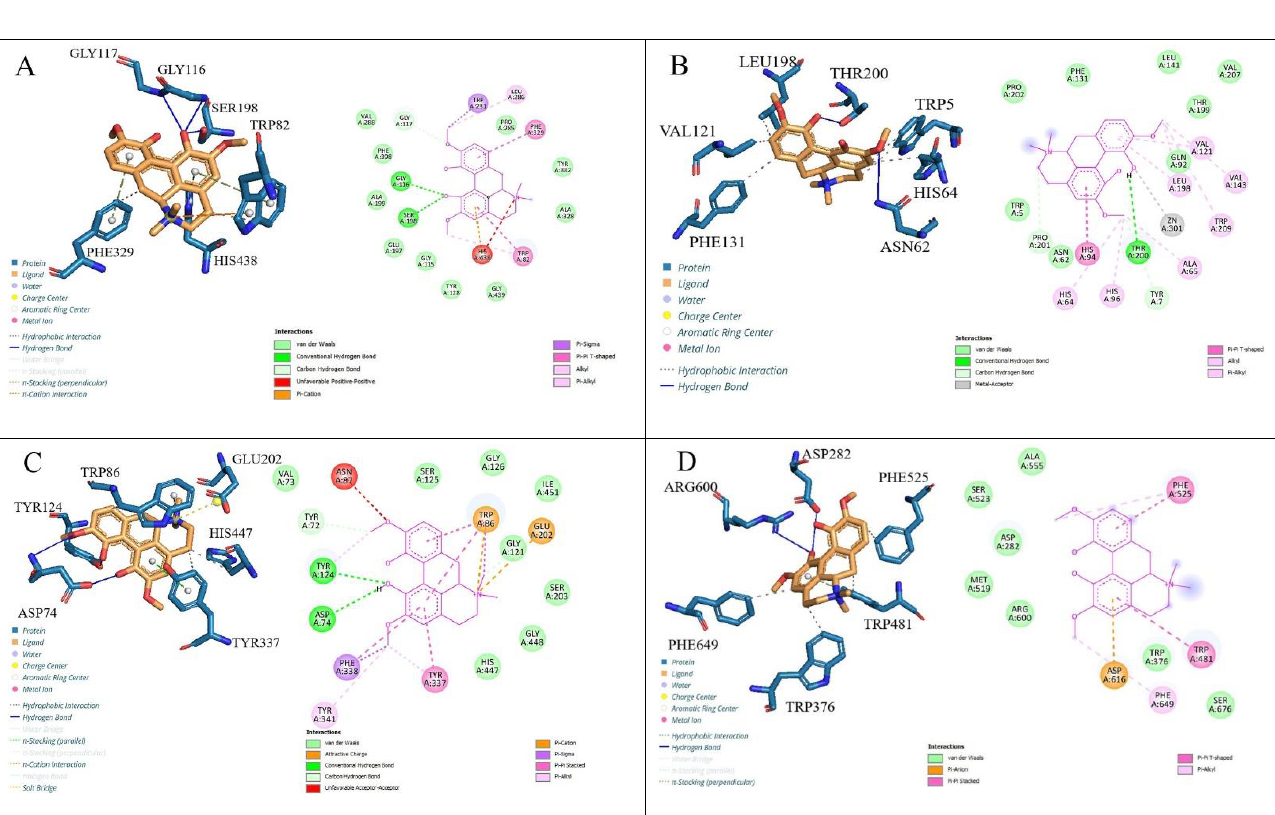
Figure 4. ( A ). The 2D and 3D interactions of BChE (6T9P) and Magnofluorine, ( B ). The 2D and 3D interactions of Carbonic anhydrase (II) enzyme (3HS4) and Magnofluorine, ( C ). The 2D and 3D interactions of AChE enzyme (4EY7) and Magnofluorine, ( D ) . The 2D and 3D interactions of α -glycosidase enzyme (5NN8) and Magnofluorine.